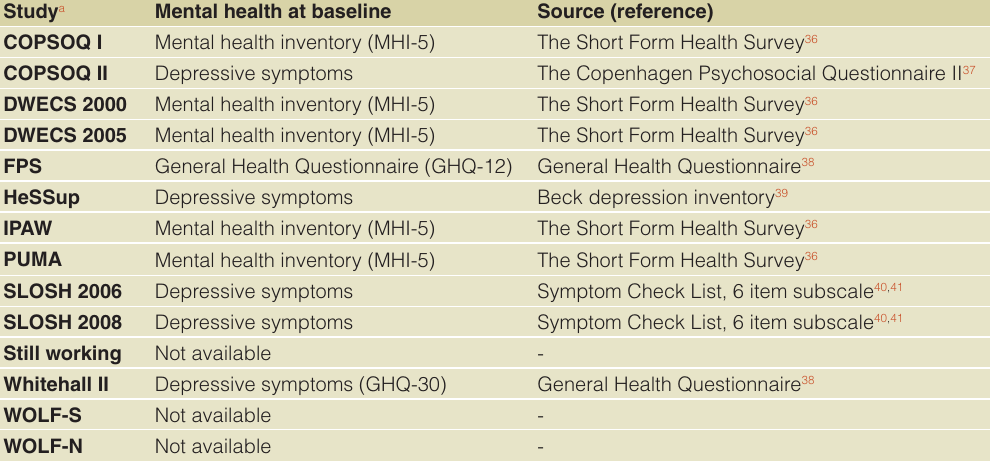
Table 5. Measures of mental health at